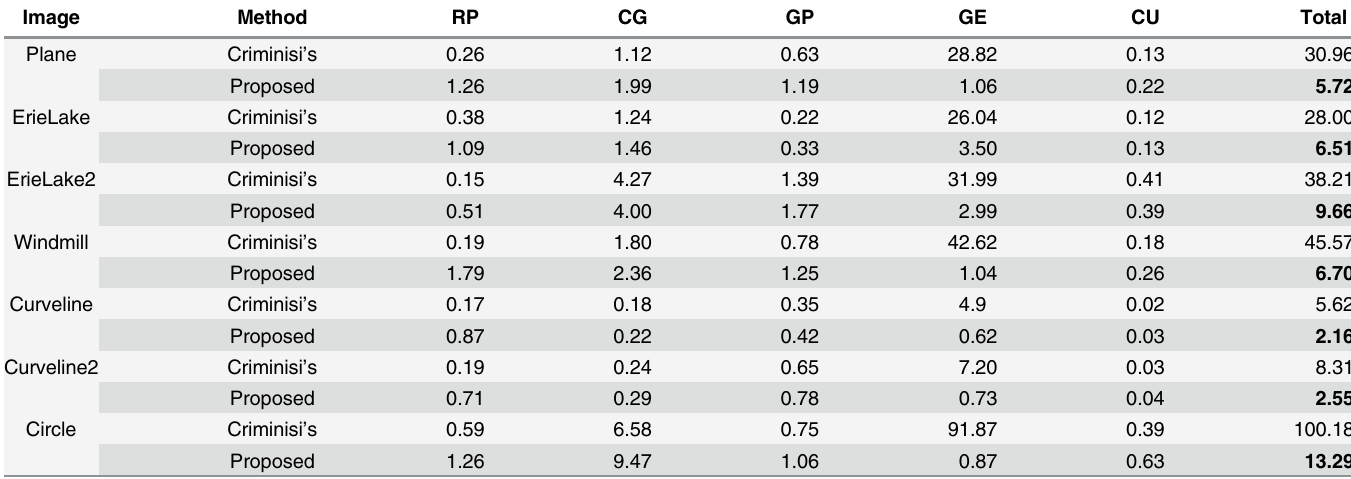
Table 1. Computation time of Criminisi ’ s method [23] and our patch-in-patch method. For simplicity, “ Ready phase ” (RP), “ Compute gradients ” (CG), “ Get priorities ” (GP), “ Get exemplars ” (GE), “ Copy&Update ” (CU). In particular, the phase “ RP ” of the proposed method includes the procedure of estimating steps. “ ErieLake2 ” and “ Curveline2 ” represent the computation time in the second row of Fig 9 and the second row of Fig 11, respectively. (Time unit: second.) Image Plane